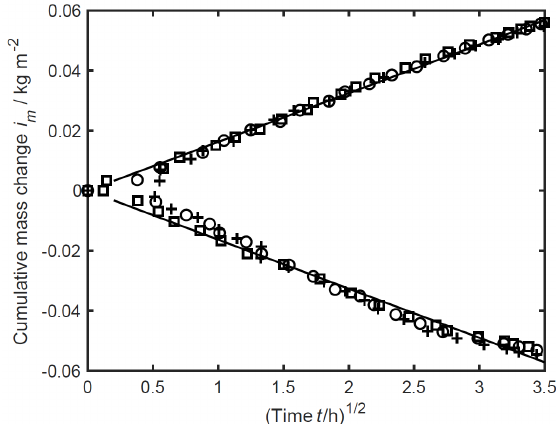
Figure 2. Change in mass of sorbed water in clay plaster, calculated from data of Maskell et al. [13]: three adsorption/desorption cycles, surface condition alternating at 12 h intervals between 50 % and 75 %RH at 23°C; set to zero at each humidity change; kg/(m 2 h 1/2 ). First cycle ; second cycle □ ; 𝑖𝑖 𝑚𝑚 d 𝑖𝑖 𝑚𝑚 / third cycle ○ 1 / 2 = A = ± 0.016 + d 𝑡𝑡